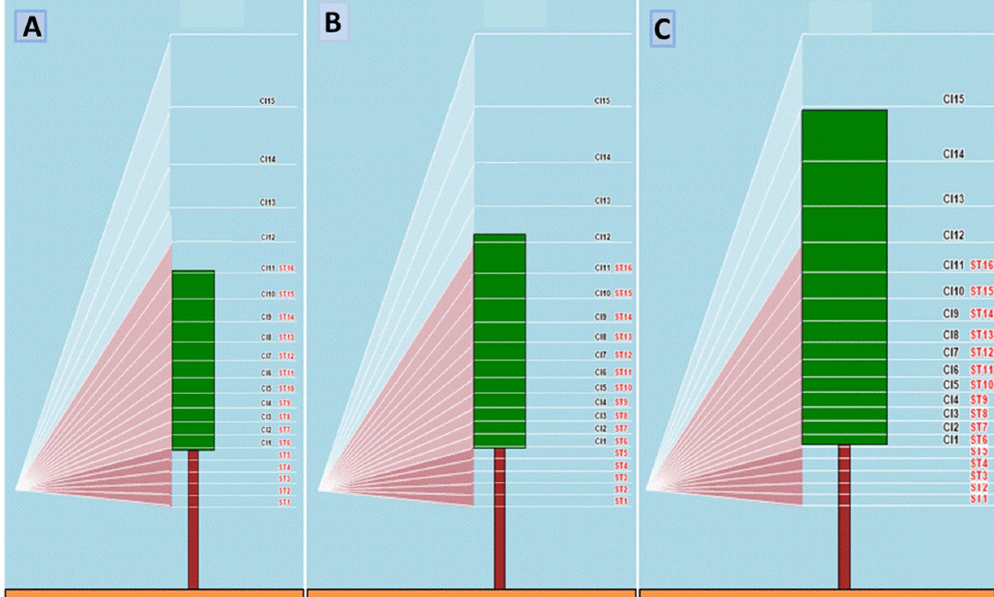
Figure 4. Operating protocol used by MECS ‐ VINE ® during the first three sampling dates of 14 May ( A ) 29 May ( B ) and 19 June ( C ). CI sectors in black label, ST sectors in red label. On each date, constant parameters were: distance between rows (250 cm), height of the supporting wire (70 cm), MECS ‐ VINE ® orientation (41°) and MECS ‐ VINE ® distance from the ground (50 cm). Canopy height was 160 cm, 175 cm and 220 cm over the three dates, whereas canopy thickness was 25 cm, 30 cm and 45 cm.